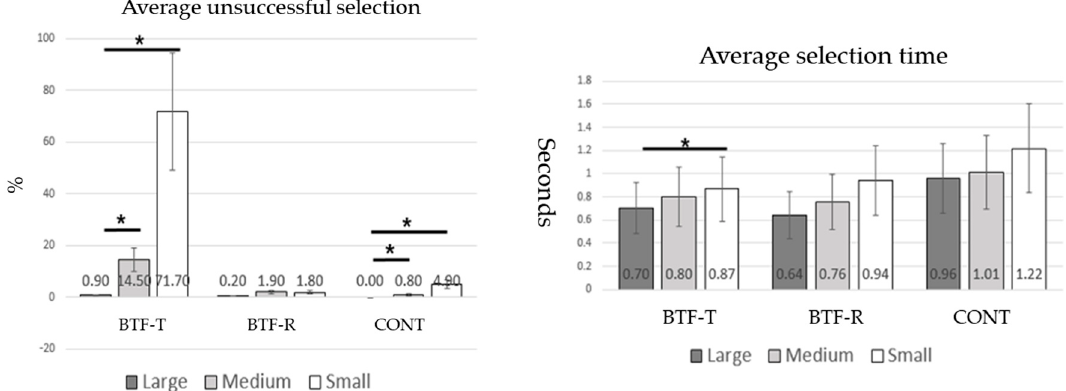
Figure 10. BTF-T is fast and accurate for large target objects. The asterisk mark (*) indicates statistically significant difference.